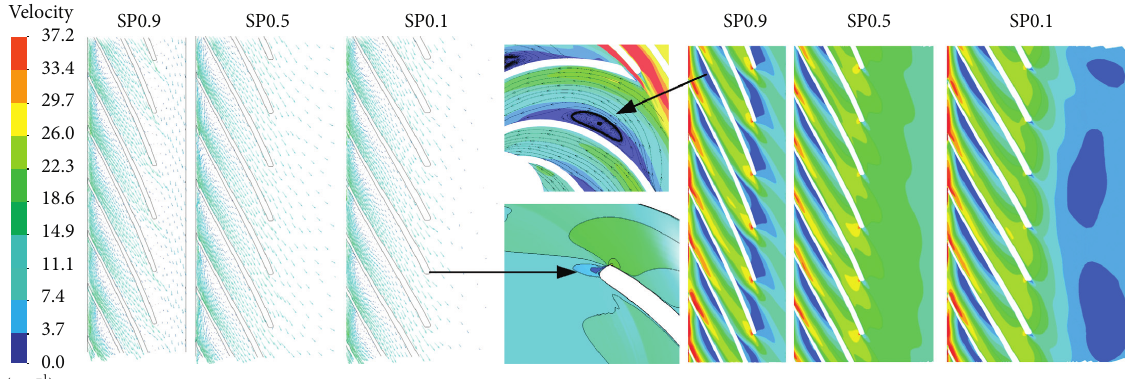
Figure 14: Streamlines in different spanwise surfaces at ( Q ) � 48m 3 /h.